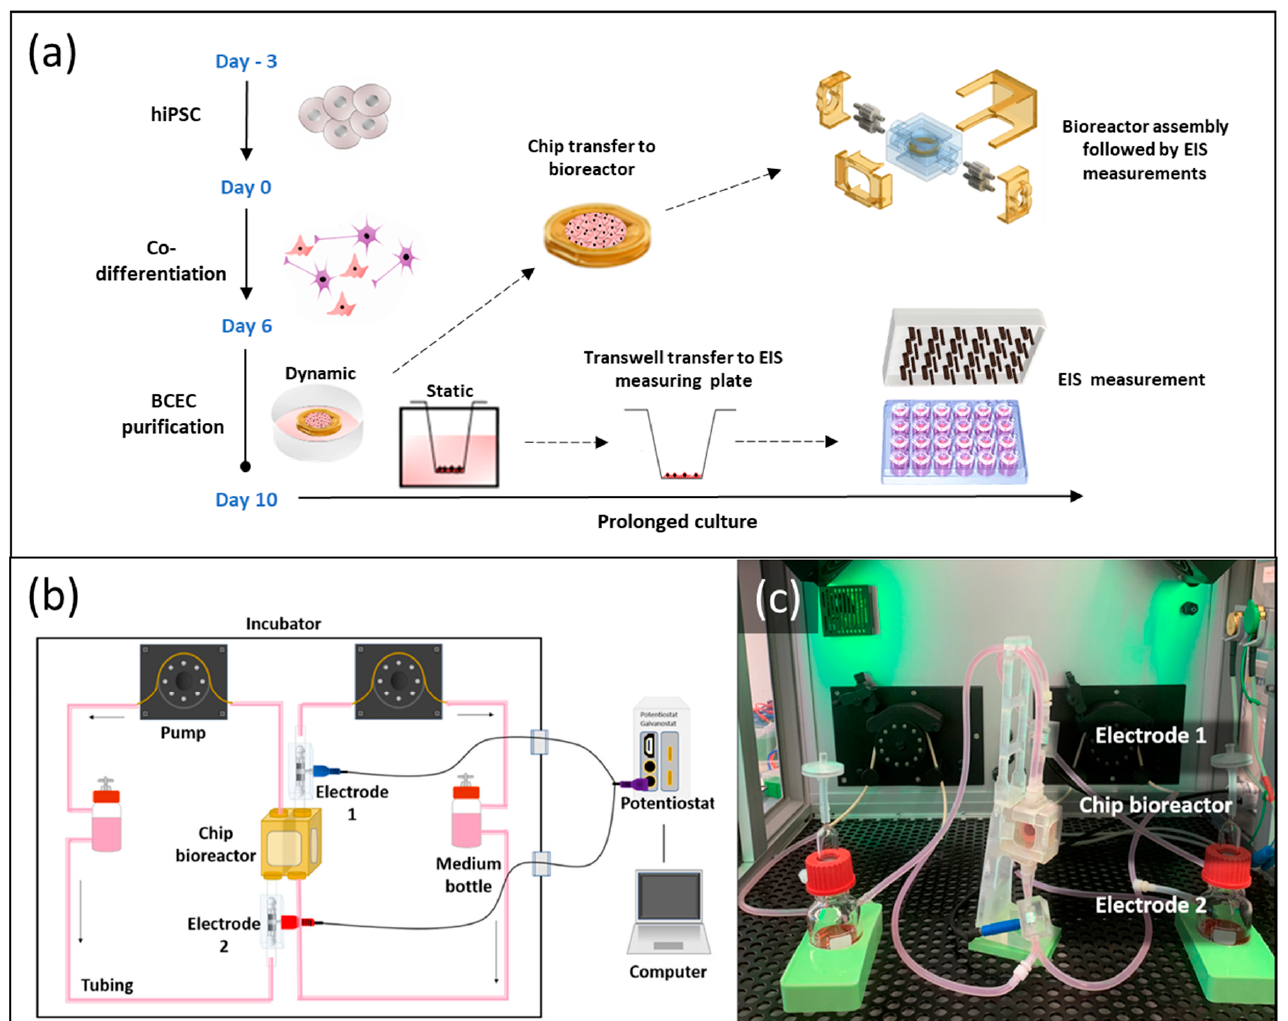
Figure 4. BCECs generation and EIS monitoring set up under static and dynamic conditions. ( a ) Overview of the differentiation process (from day 3 to day 10) of hiPSCs towards BCECs. On day 10 of differentiation, the membrane chip was transferred to a bioreactor system for dynamic culture; ( b ) schematic of bioreactor system; ( c ) photographical overview of the whole bioreactor system with attached electrodes for online monitoring of the dynamic culture of BCEC in vitro models.